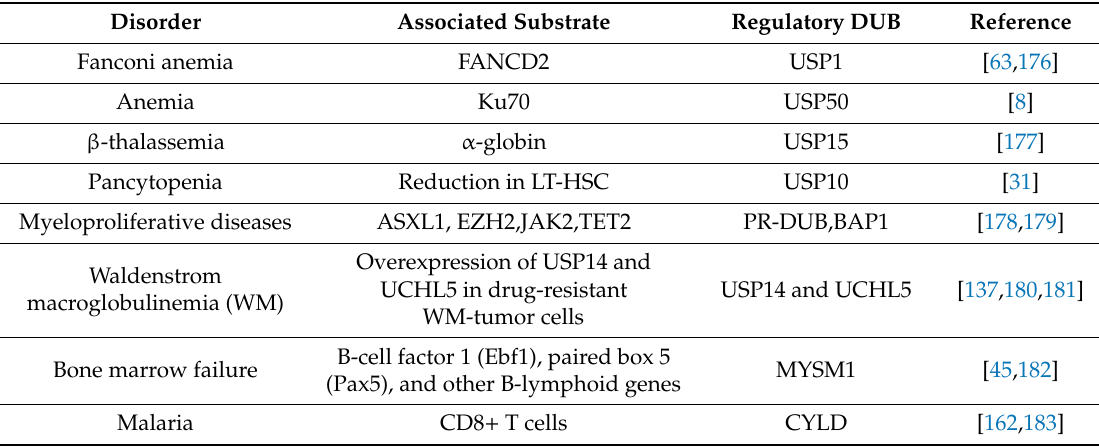
Table 1. List of DUBs involved in hematological